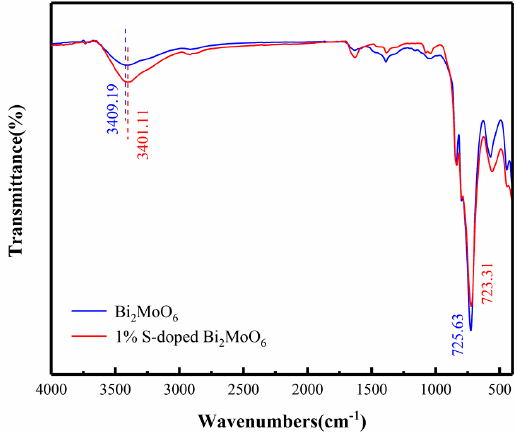
Figure 5. Fourier transform infrared spectroscopy (FT-IR) spectra of Bi 2 MoO 6 and 1% S-doped Bi 2 MoO 6.